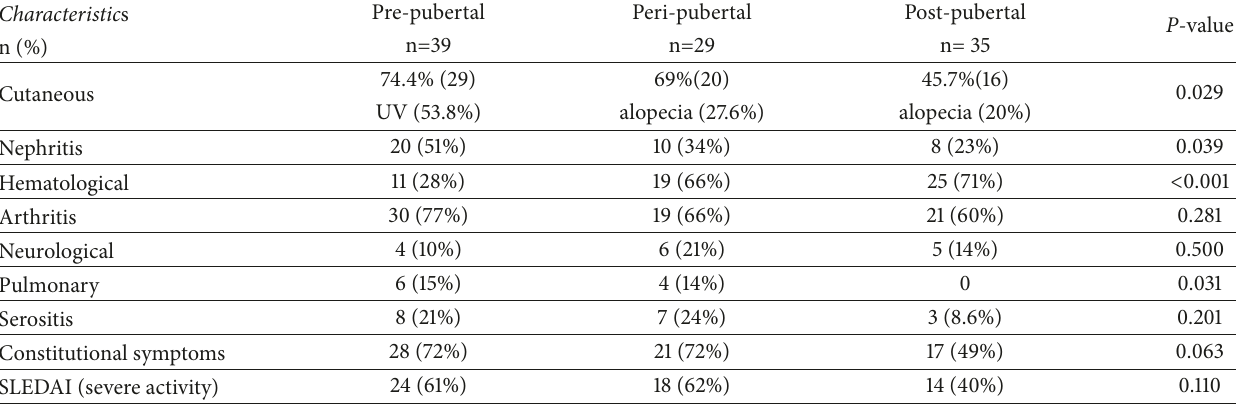
Table 2: Clinical manifestations of systemic lups erythematosus (SLE) patients according to age at onset of disease.